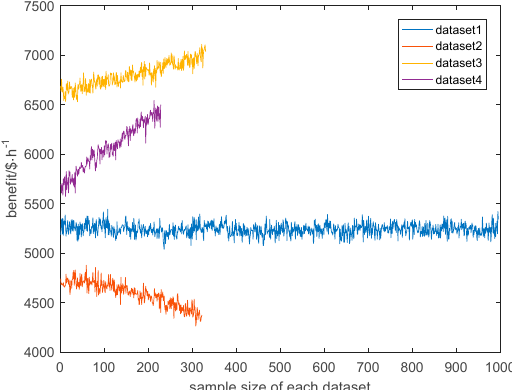
Figure 4. Economic benefit curve of each dataset.